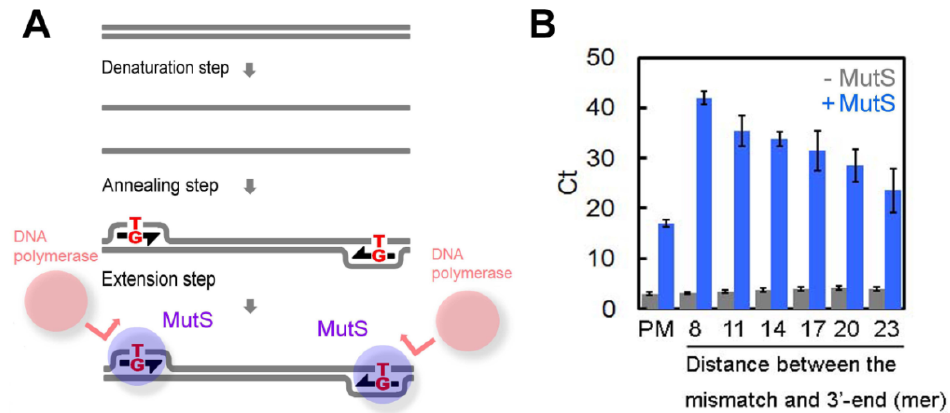
Figure 3. Model for Tth MutS suppression of mismatched primer-dependent amplification. ( A ) Schematic representation of the model. Mishybridization of primers at the annealing step generates mismatched bases that are tightly bound by MutS, which block the approach of DNA polymerases to the 3' end of the primers; ( B ) The 80-bp perfectly matched template was amplified by AmpliTaq Gold DNA polymerase by real-time PCR using mismatched primers. The threshold cycle ( C ) was determined and plotted against the t distance between the mismatched bases and 3' end of the primer (8, 11, 14, 17, 20 or 23 bp). PM, perfectly matched primer. Blue and gray bars indicate experiments with or without 1.0 μ M Tth MutS, respectively. Experiments were repeated three times. Bars indicate standard